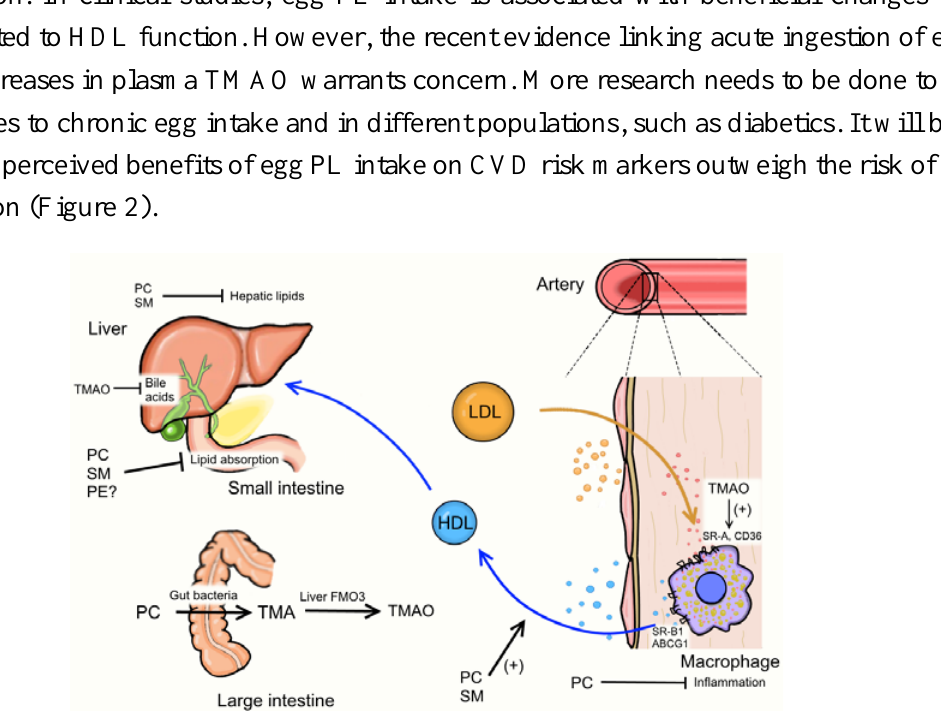
Figure 2. Potential pathways egg phospholipids could influence atherosclerosis. Egg phospholipids may lessen risk for cardiovascular disease (CVD) via reducing lipid absorption (PC, SM), reducing hepatic lipids (PC, SM), increasing HDL cholesterol efflux (PC, SM), and reducing inflammation (PC). Egg PC may also influence CVD risk via gut microflora-dependent catabolism to TMA and liver conversion to TMAO. TMAO may increase CVD risk via increasing macrophage scavenger receptors and decreasing RCT via reduced bile acid synthesis. Abbreviations: ABCG1, ATP-binding cassette transporter G1; CD36, Cluster of Differentiation 36; FMO3, flavin containing monooxygenase 3; HDL, high-density lipoprotein; LDL, low-density lipoprotein; PC, phosphatidylcholine; PE, phosphatidylethanolamine; SM, sphingomyelin; SR-A, scavenger receptor A; SR-B1, scavenger receptor B1; TMA, trimethylamine; TMAO, trimethylamine N